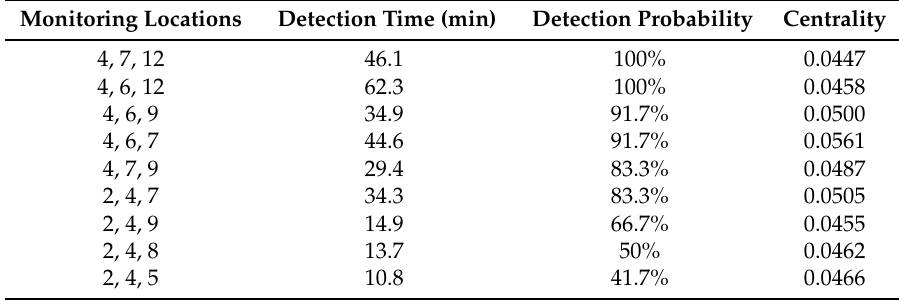
Table 9. Pollution detection time, pollution detection probability and centrality in Pareto frontier with reserved monitoring location 4.